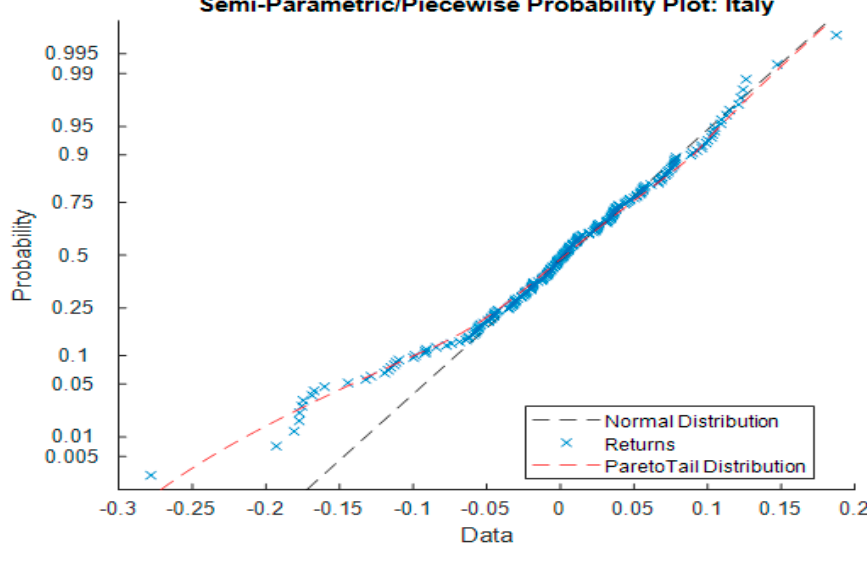
Figure 1. Semi-parametric/piecewise probability plots for Italy and Brazil.